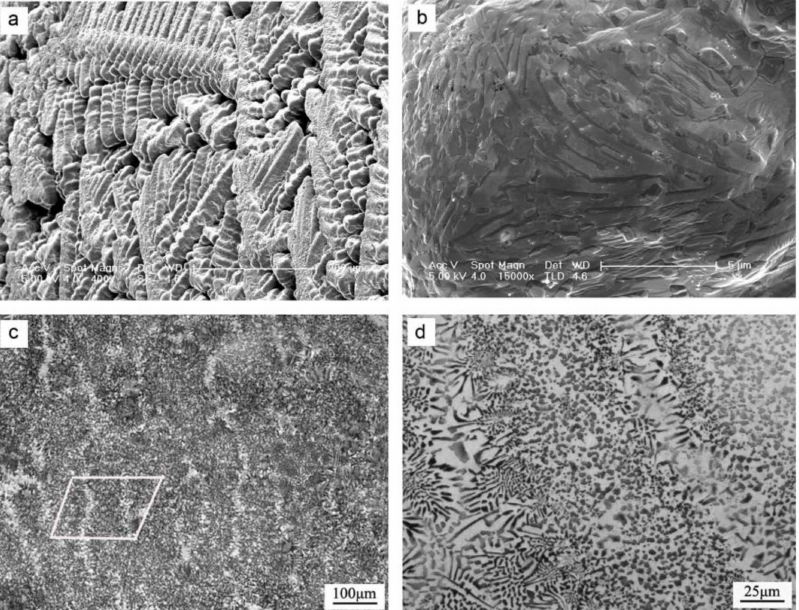
Figure 6. Microstructures of (Ag-28.1Cu)-1Sb alloy undercooled by 85 K, ( a ) the surface structure with dendritic morphology at low magnification, ( b ) lamellar eutectics in the surface dendrite arms at high magnification, ( c ) the internal structure with dendritic morphology at low magnification, and ( d ) anomalous eutectics and the lamellar eutectics around them in the quadrilateral region at high